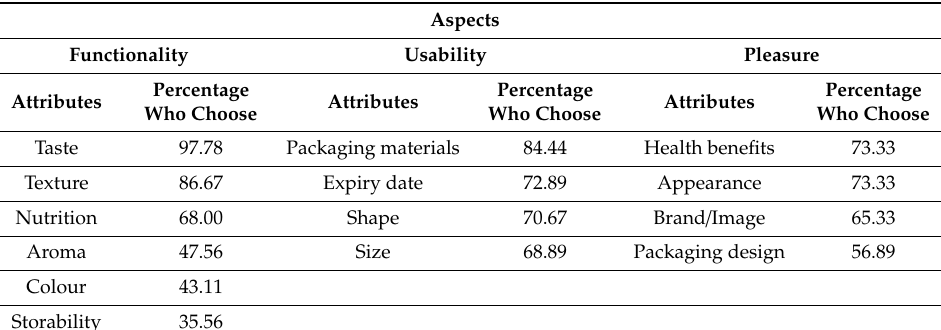
Table 3. Consumer preferences for each attribute of each